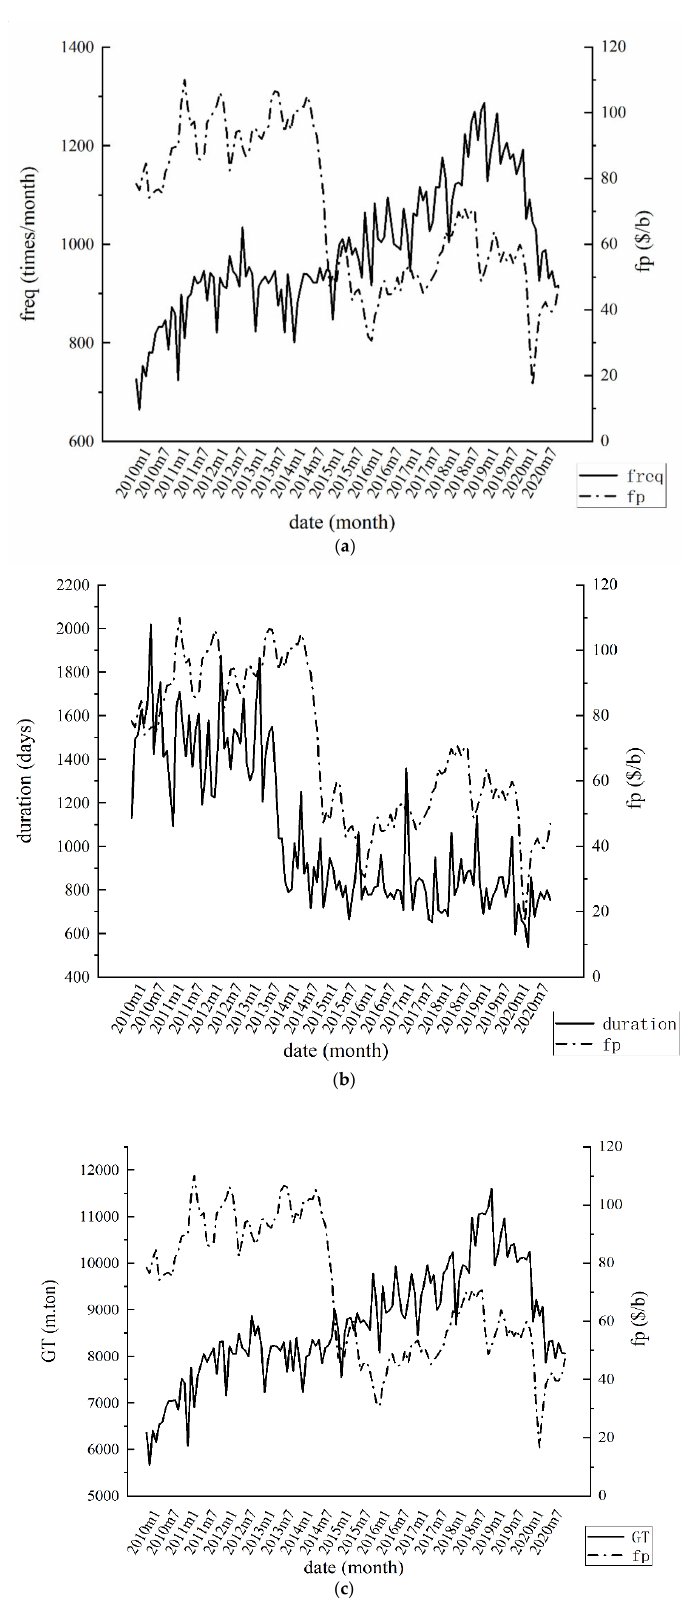
Figure 3. ( a ) The oil future price and the frequency of tankers’ port-calls per month. ( b ) The oil future price and total docking time of all the tankers per month. ( c ) The oil future price and the sum of all the tankers’ gross tonnage per month. the tankers’ gross tonnage per